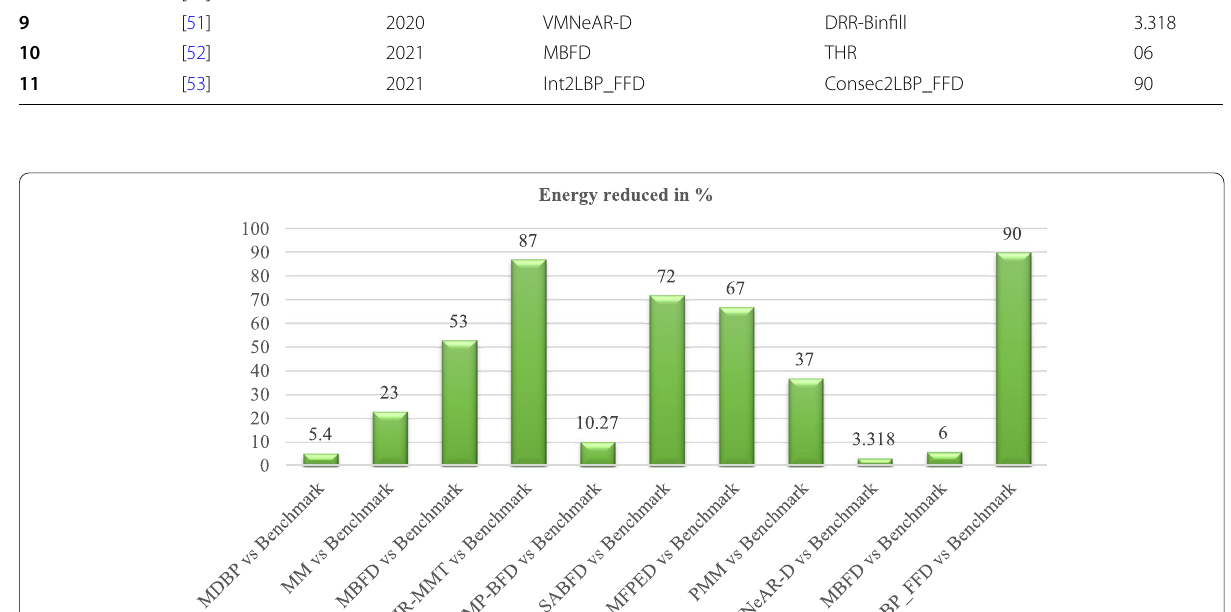
Fig. 10 Energy reduction using Heuristic techniques vs